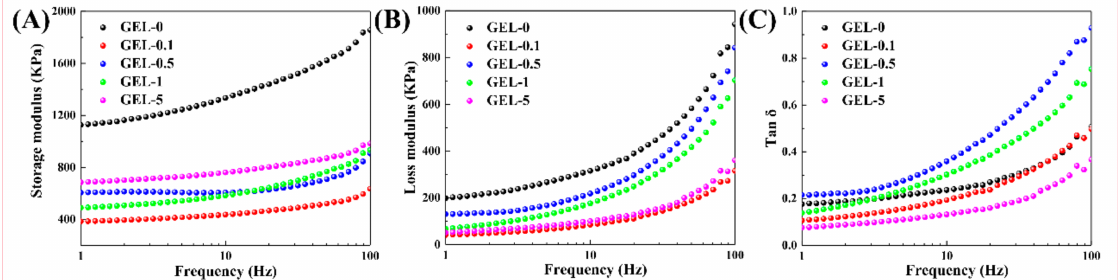
Figure 7. Viscoelasticity of CDN-gels. ( A ) Storage modulus; ( B ) loss modulus; ( C ) tan δ